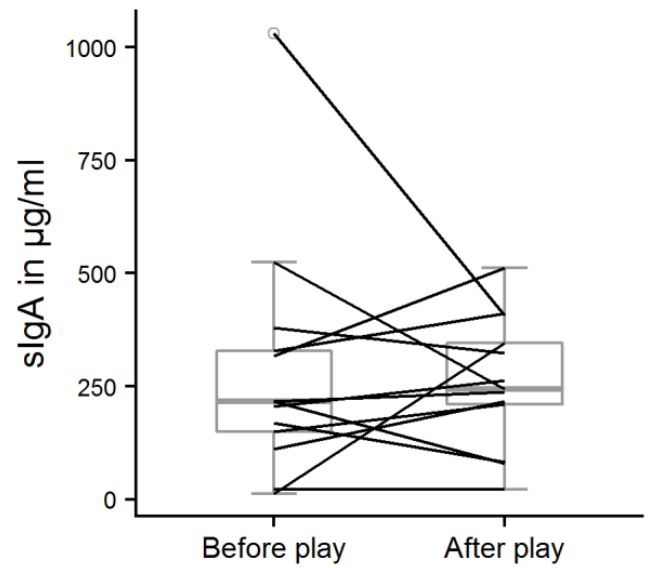
Figure 6. Salivary sIgA concentrations before and after the play test situation. One-sample sign test, n = 13, s = 7, p = 0.39.